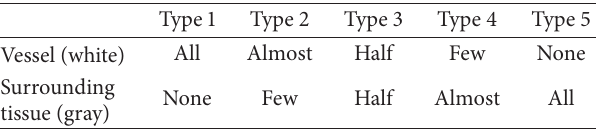
Table 1: Five different region types derived according to their spatiochromatic